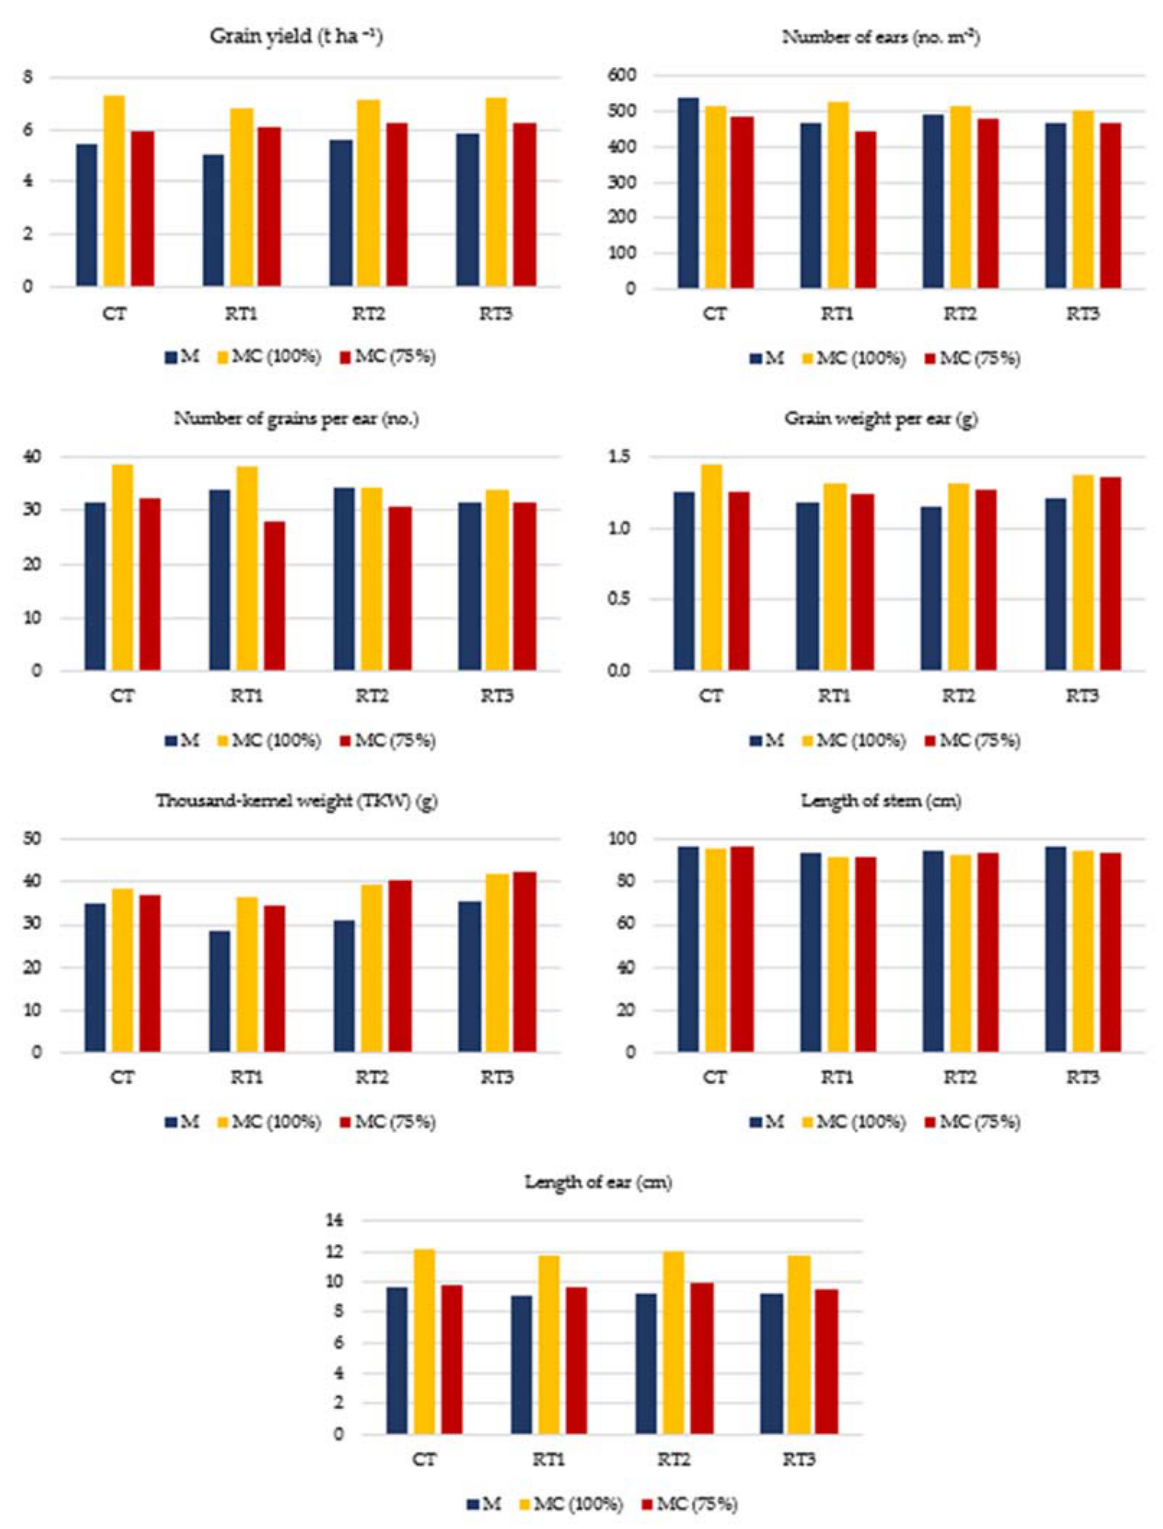
Figure 1. Interaction of the tillage system and weed control method in determining grain yield and crop components of spelt wheat.